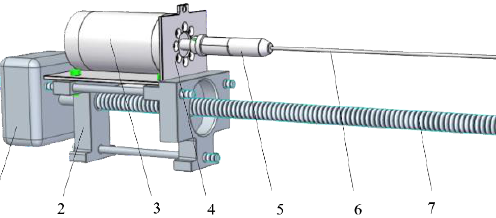
Figure 4. The dual motor discrete transmission structure of microdestructive tree-ring measurement system. (1) Stepper motor; (2) rear sliding base; (3) DC servomotor; (4) motor base; (5) drill bit clamp;